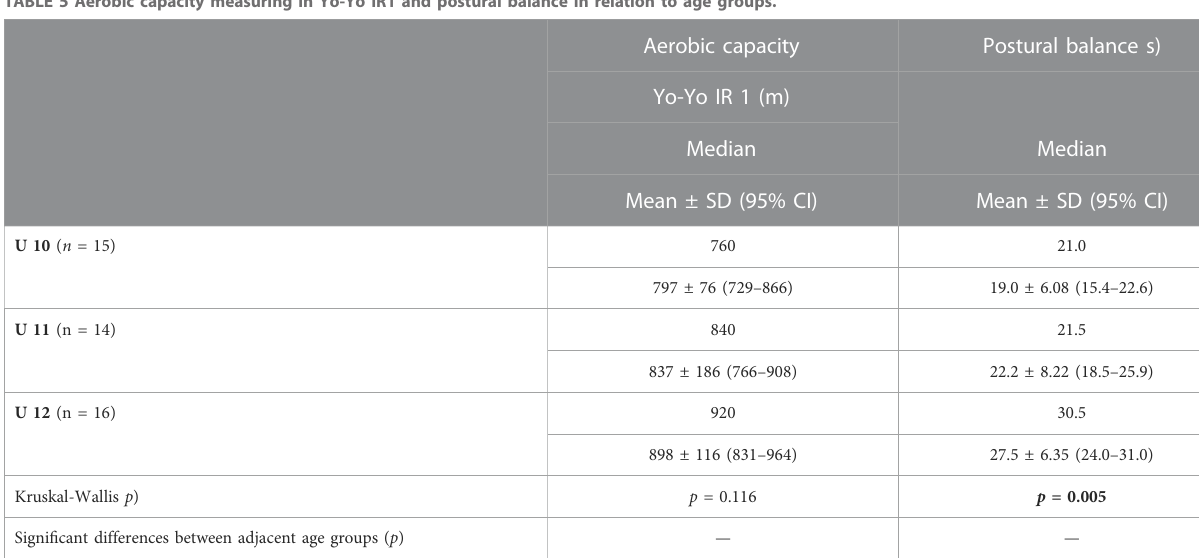
TABLE 5 Aerobic capacity measuring in Yo-Yo IR1 and postural balance in relation to age groups.